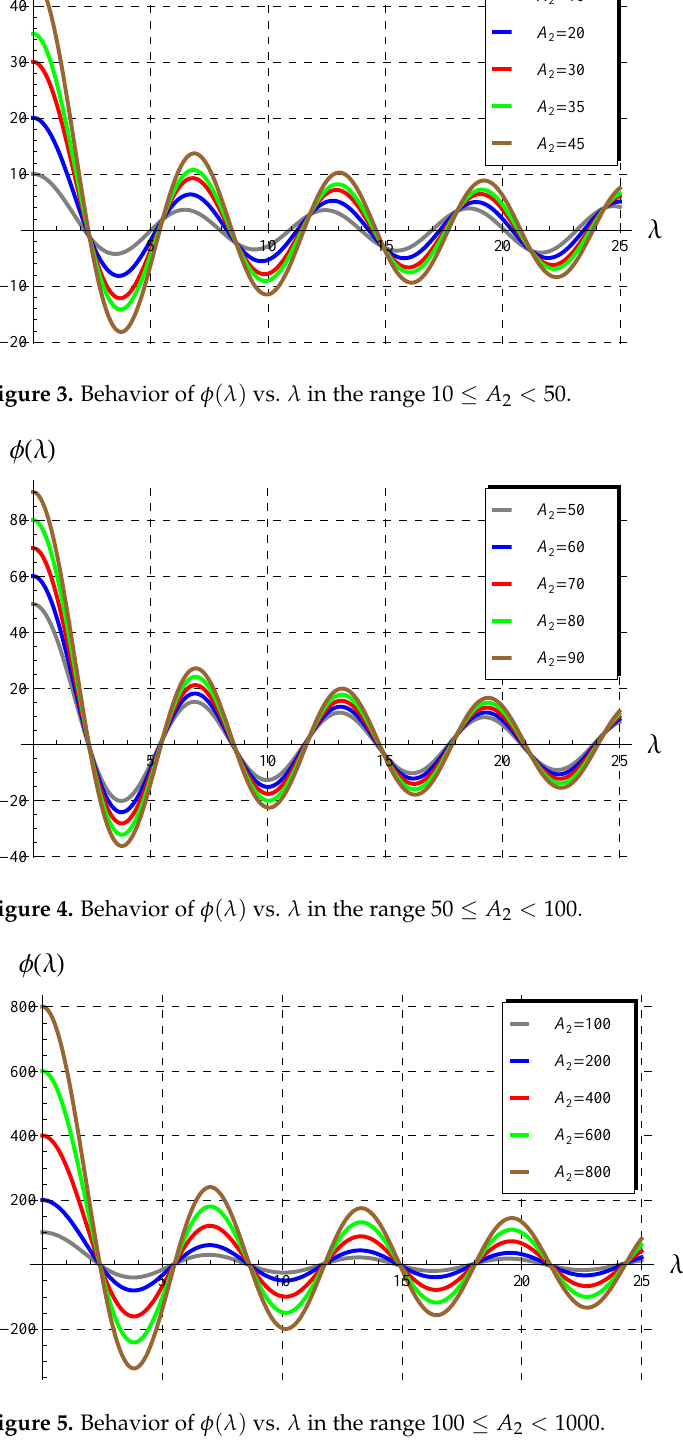
Figure 5. Behavior of φ ( λ ) vs. λ in the range 100 ≤ A 2 <